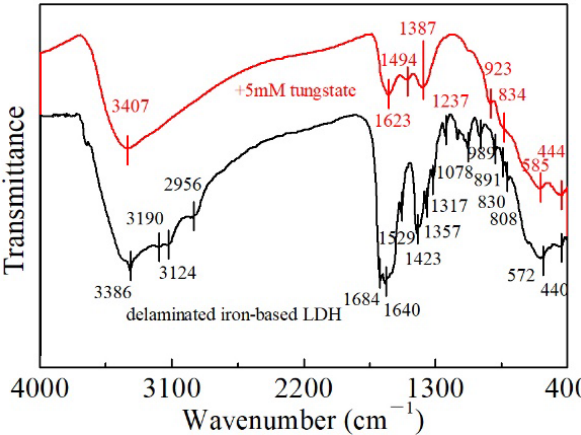
Figure 12. FT-IR spectra of delaminated iron-based LDH before and after reaction with 5 mM tungstate. Evidence for the occurrence of surface tungstate complex came from the XPS analyses as well (Figures 13, S6 and S7). The main elements in delaminated iron-based LDH are Mg, Fe, N, C, and O. Tungstate removal by delaminated iron-based LDH seems unrelated to the Mg atoms in its structure in view of the slim difference in the Mg 2p spectra of the solid samples before and after the tungstate sorption (Figure S6b). The N 1s spectra of the non-delaminated iron-based LDH and L-asparagine were used to calibrate the standard binding energies of the nitrate and amide groups. As shown in Figure S7b, for the non- delaminated LDH, only the characteristic peak of nitrate (406.83 eV) was displayed in the N 1s spectra, while the characteristic peak of the amide groups appeared at a lower binding energy (398–402 eV). In view of this, the N 1s spectra of the delaminated LDH before and after tungstate sorption were analyzed again. The characteristic peak of the nitrate groups was barely visible for the delaminated LDH, while it showed a sharp peak of amide groups at 399.34 eV, indicating that L-asparagine, instead of nitrate, did enter the interlayers during the preparation and delamination of iron-based LDH. However, after tungstate sorption, the binding energy of N 1s spectra was almost not changed, while its peak intensity reduced significantly, indicating that amide groups in delaminated iron- based LDH derived from L-asparagine could be replaced by aqueous tungstate to a high degree during its rehydration. The characteristic peaks of W 4f, with binding energies of 34.98 and 37.03 eV, were detected in the reacted samples (Figure S6d). Compared to the reported binding energies of various tungstate compounds (Ng and Hercules, 1976; Nefedov et al., 1982; Chowdari et al., 1992), these two peaks were attributed to the chemical bonds of WO 4 2 − in W 4f7/2 and W 4f5/2, respectively. This confirms that